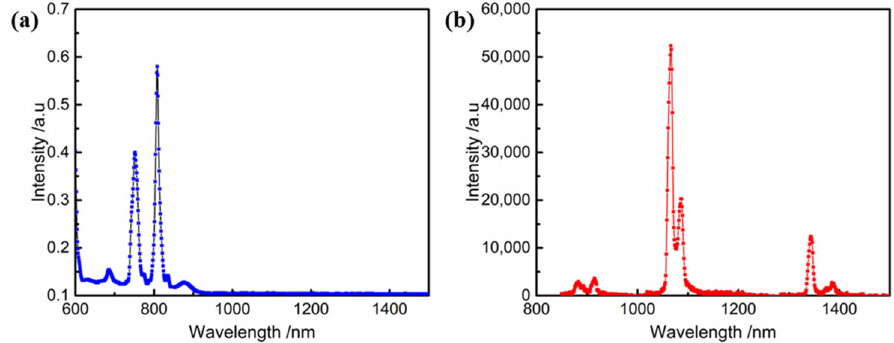
Figure 1. ( a ) Absorption and ( b ) emission spectra of Nd:YVO 4 crystal at room